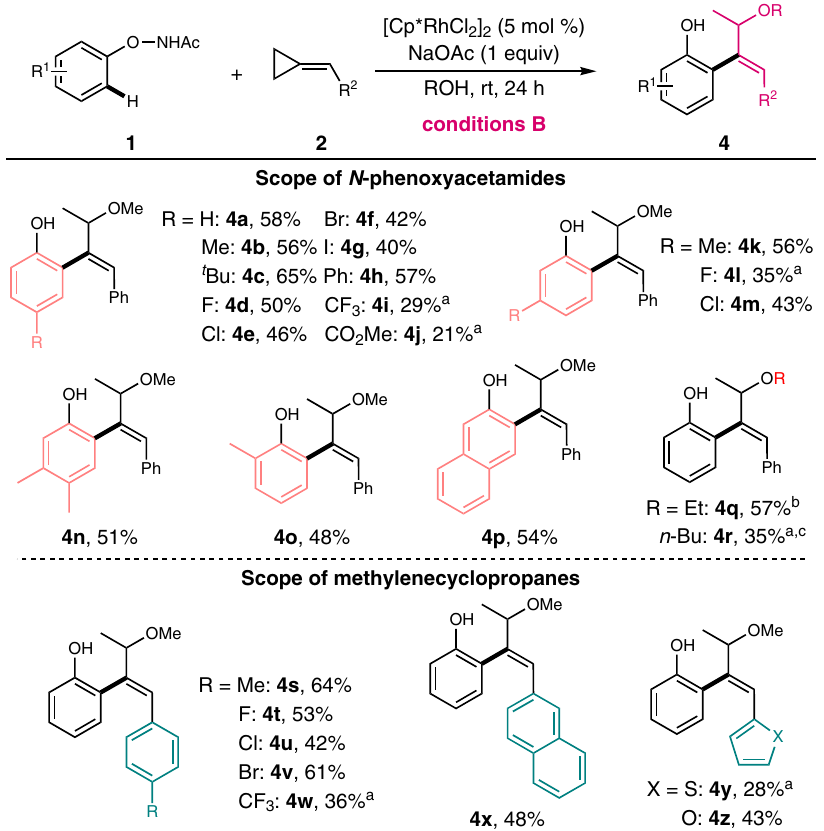
Fig. 3 Substrate scope for the synthesis of allyl ethers. Reaction conditions B: 1 (0.2 mmol), 2 (0.4 mmol), [Cp*RhCl 2 ] 2 (5 mol%), and NaOAc (1 equiv) in MeOH (0.2 M) at room temperature for 24 h under air; isolated yields were reported. a Diene derivative was obtained as the main product. b EtOH was used instead of MeOH. c n -BuOH was used instead of